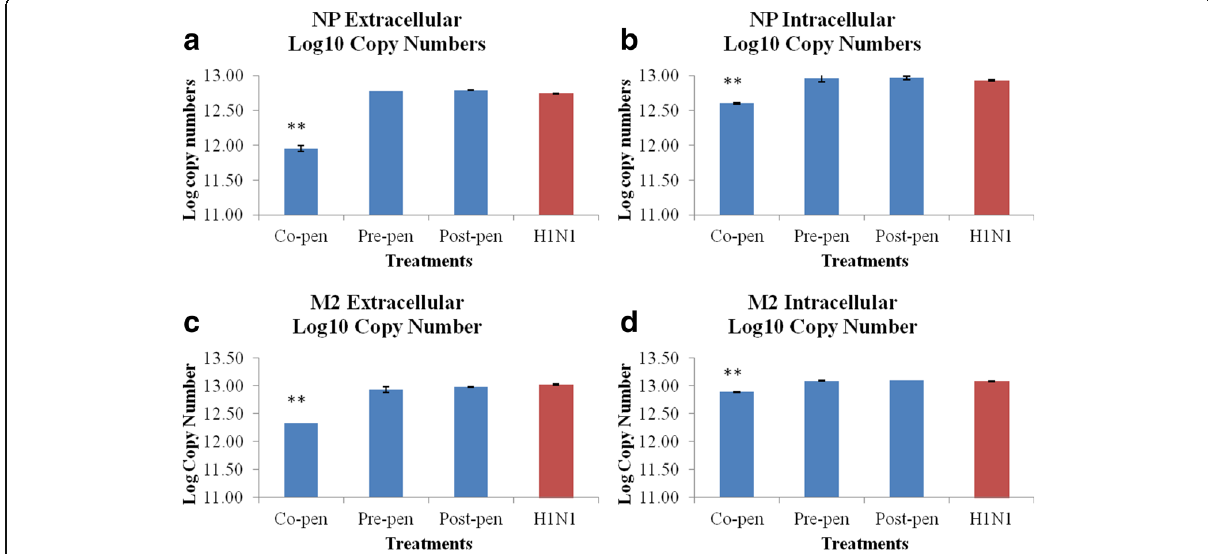
Fig. 4 The charts show the NP ( a , b ) and M2 ( c , d ) genes extracellular and intracellular Log 10 copy numbers in different combination treatments as compared to H1N1-inoculated sample. **: indicates the highly significant differences with the infected positive control ( p <